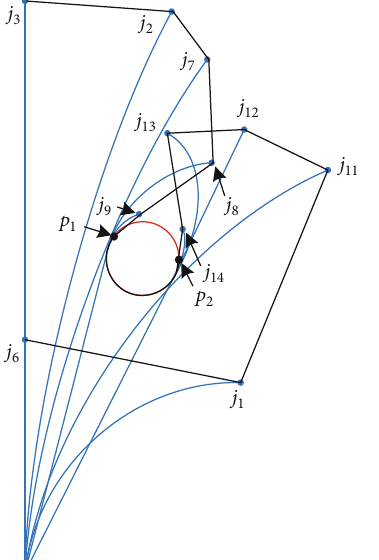
Figure 11: Landing footprints for Case 3.